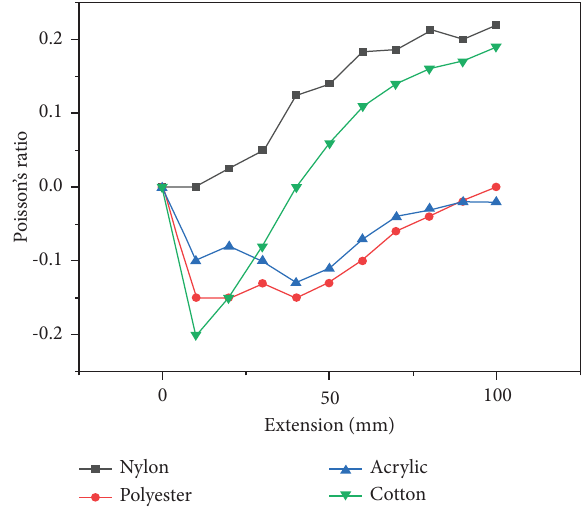
Figure 14: Negative Poisson’s ratio of zigzag structures.